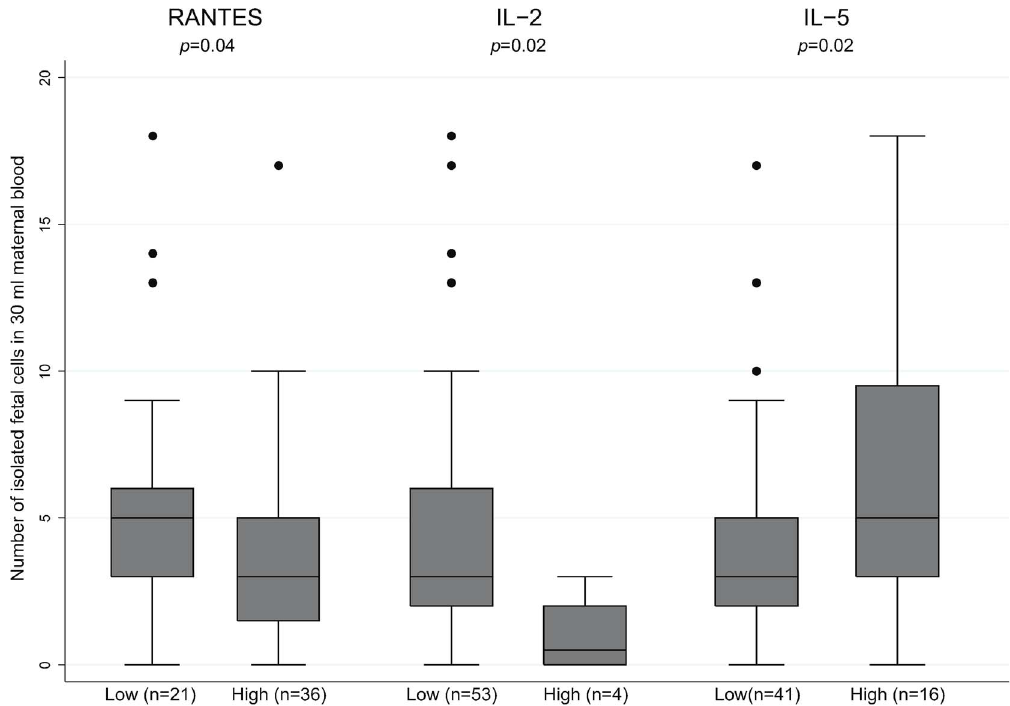
Figure 3. The number of isolated fetal cells in 30 ml of blood in relation to low or high levels of different selected cytokines. Three of the cytokines (RANTES, IL-2 and IL-5) had a significant association with the number of extravillous trophoblasts in maternal blood.